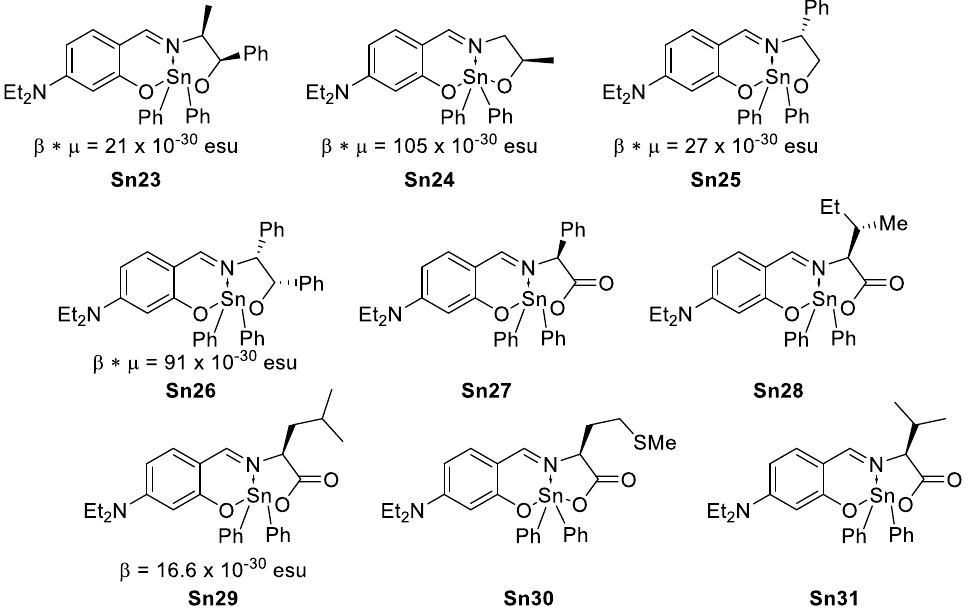
Figure 42. Aminoalcohols and aminoacids derived Schiff-base-Tin complexes.